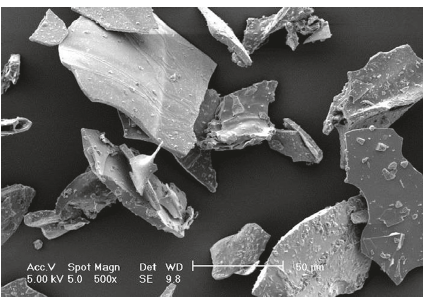
Figure 5: Irregular morphology of GEA TM 0.125 aerogel measured by SEM with a top surface view with a magnification of ×